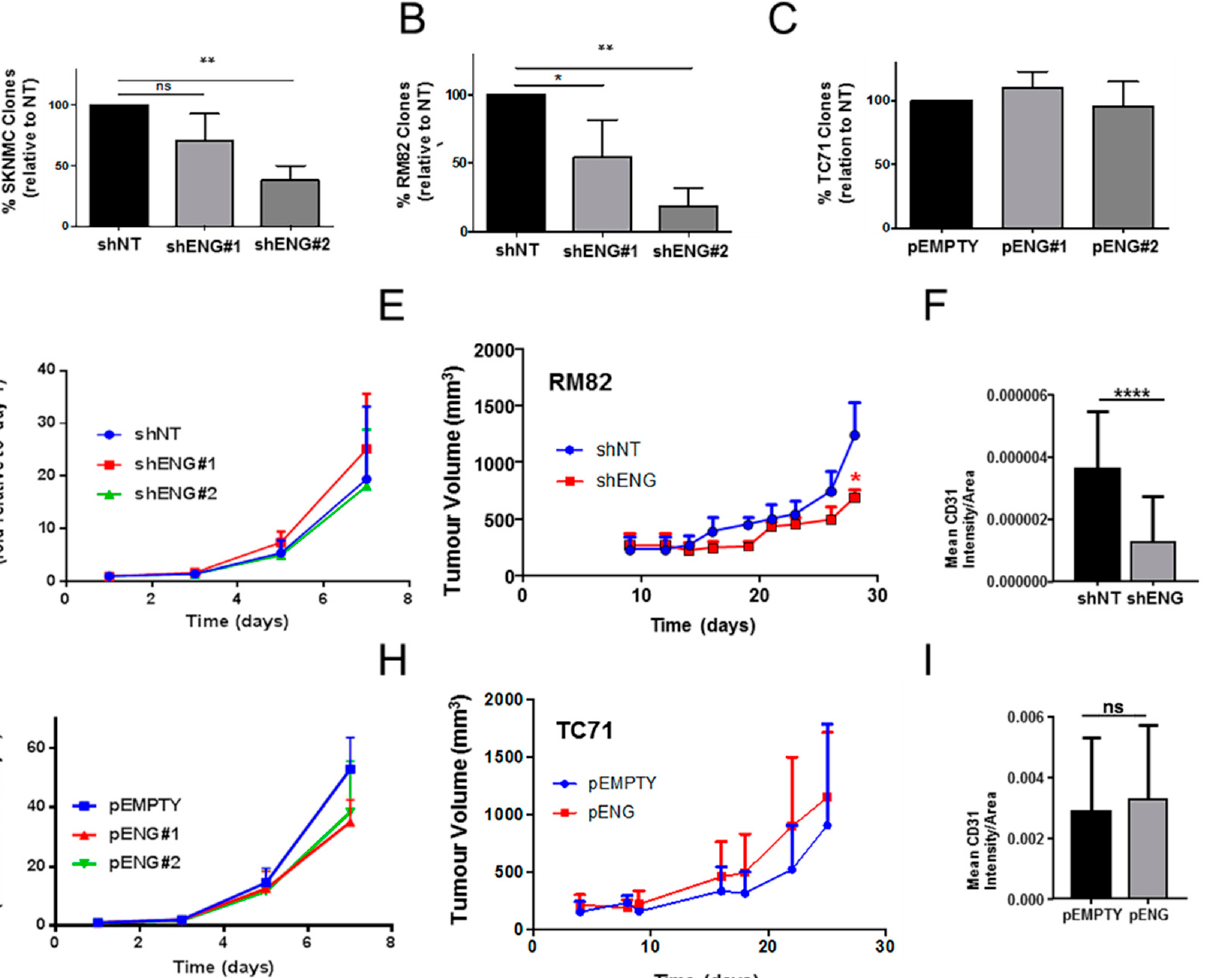
Figure 2. ENG downregulation in ES cells impairs clonogenicity, without affecting cell proliferation, independently of SMAD phosphorylation. ( A – C ) The clonogenic capacity was impaired when ENG was downregulated in both RM82 ( A ) and SK-N-MC ( B ) cells, while there was no improved clono- genic potential in the upregulated model ( C ). ( D ) In vitro proliferation was not affected by the downregulation of ENG in the RM82 model. ( E ) In vivo, the downregulation of ENG slightly im- paired the ES tumor growth, reaching significance at the endpoint. ( F ) Expression of the vessel marker CD31 was significantly decreased when ENG was downregulated in the shENG model in vivo, as determined by IHC and quantified by Fiji. ( G – H ) In vitro cell proliferation ( G ) and in vivo tumor growth ( H ) were not affected by ENG upregulation in the TC71 pENG model. ( I ) Differences in CD31 expression were not significant in the ENG-overexpressing model in vivo, as detected by IHC and quantified by Fiji. ( J ) Tumoral downregulation/upregulation of ENG were maintained in the shENG and the pENG models in vivo, respectively, as determined by IHC at the end of study.